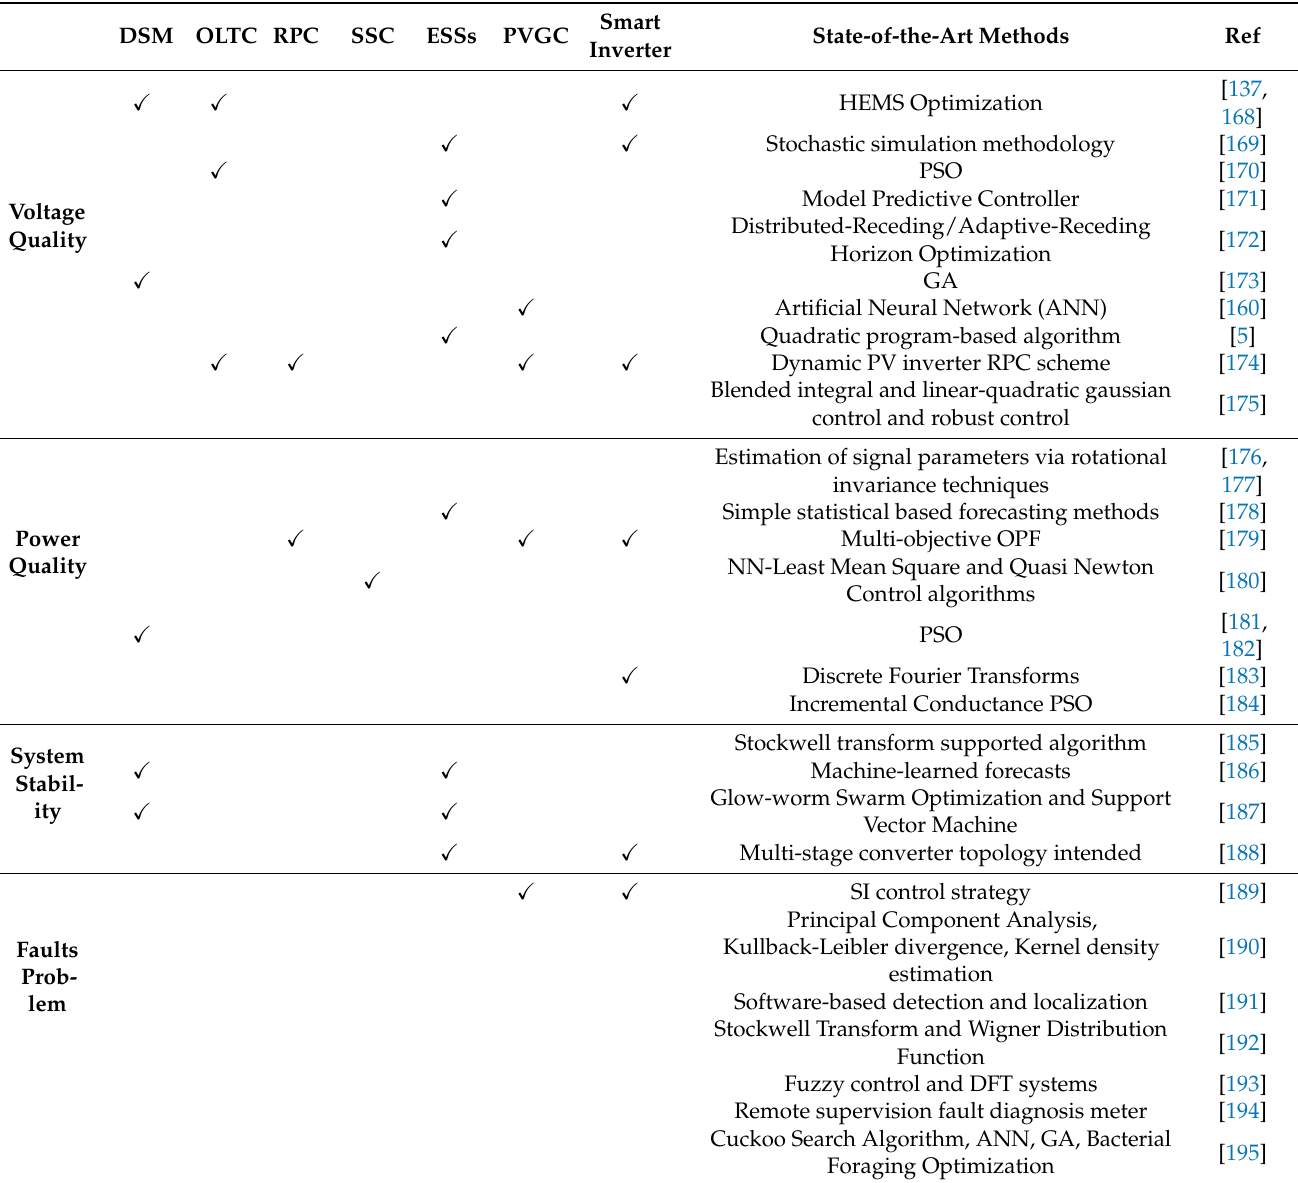
Table 7. State-of-the-art solutions